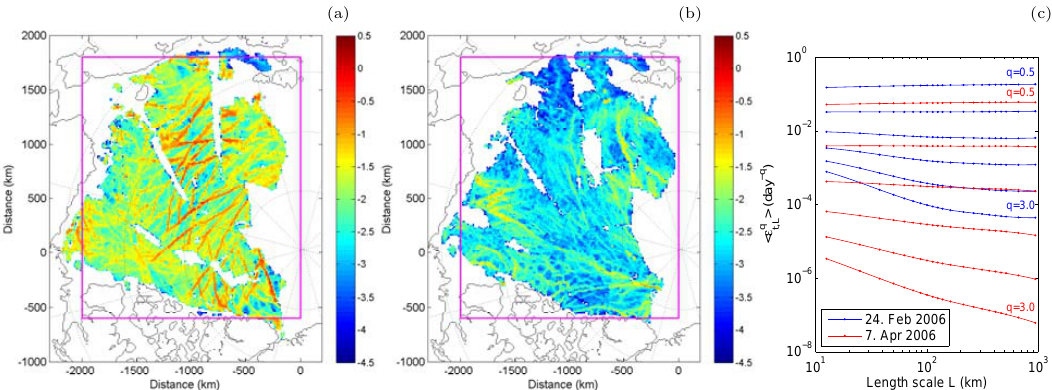
Fig. 1. Total sea ice deformation rate ˙ (cid:15) t in the Arctic on 24 February ( ¯ τ a = 0 . 24Nm − 2 ) and 7 April 2006 ( ¯ τ a = 0 . 03Nm − 2 ): maps of ˙ (cid:15) t (in day − 1 ), shown in a logarithmic color scale (a, b) ; and moments m q,L for a range of length scales L and powers q (c) . The boxes in (a) and (b) show the area within which ¯ τ a was calculated. The lines in (c) are drawn for q increasing from 0.5 to 3.0 with a step of